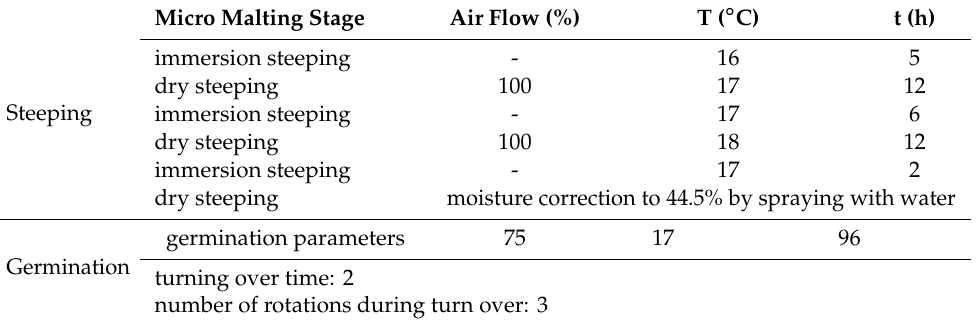
Table 1. The applied micro malting scheme of barley